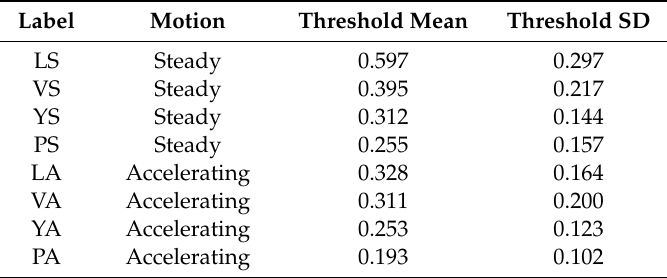
Table 4. Descriptive statistics of the thresholds.